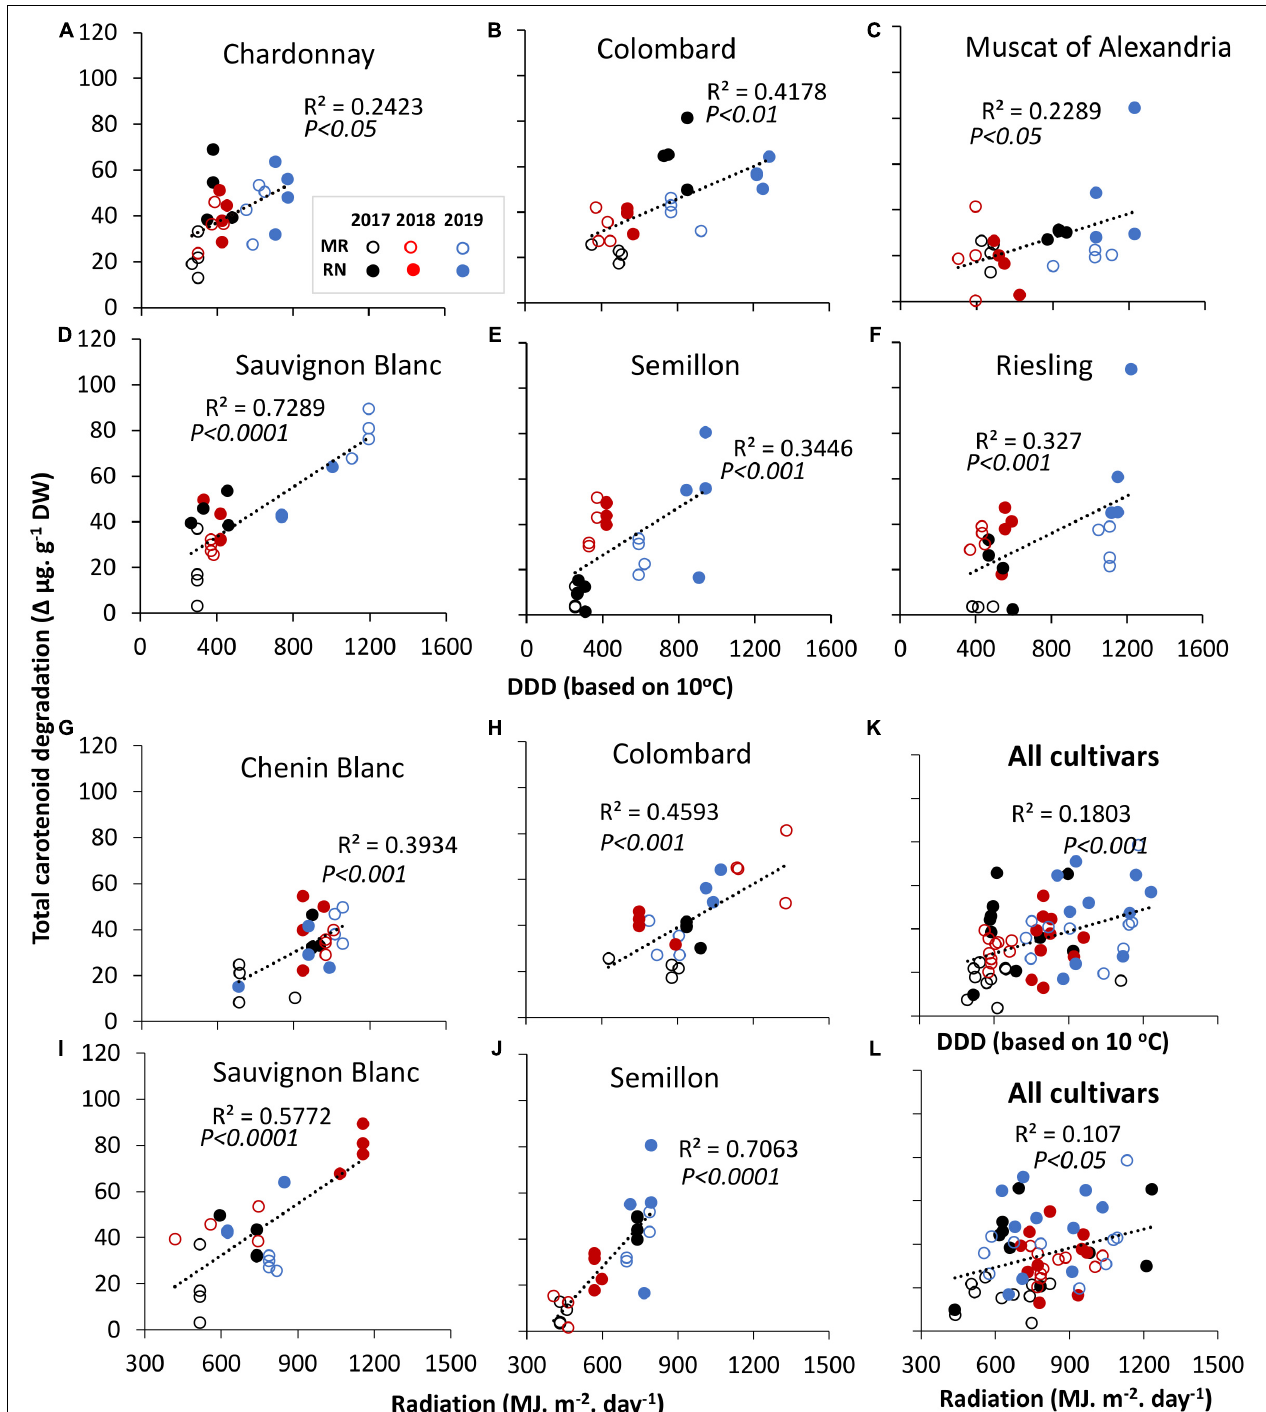
FIGURE 2 | Linear correlation of total carotenoid degradation against accumulated daily degree days (DDD) (A–F) and daily summed radiation (G–J) that were calculated from véraison to harvest in white cultivars grown at Mitzpe Ramon (MR) and Ramat Negev (RN) during 2017–2019. (K,L) Represent correlations of total carotenoid degradation across all cultivars ( n = 4 replicates × 10 cultivars × 2 locations × 3 seasons) with DDD and radiation, respectively. In each season, data are values of four biological replicates. Only significant correlations are shown. Circles denote the MR (open) and RN (closed) vineyards. Colors indicate cultivars grown in 2017 (black), 2018 (red), and 2019 (blue). See Supplementary Table 2 .